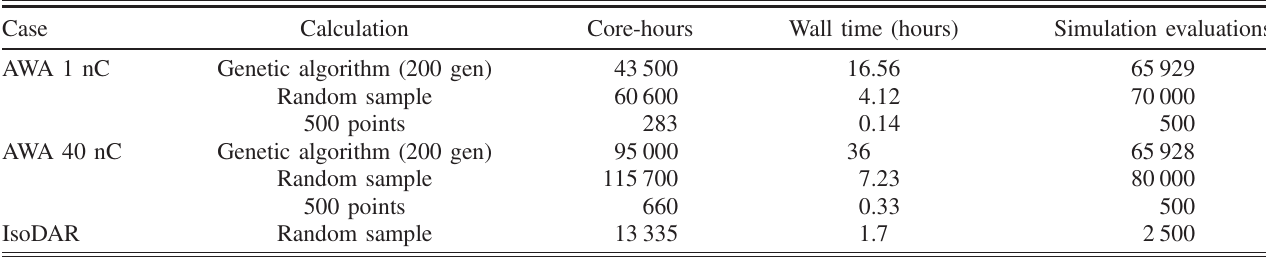
TABLE V. Overview of the datasets from the physics simulations and the computational resources used for generating them. Note that we found that to make accurate surrogate models we needed many fewer randomly sampled points than were initially generated. For the GAs, 2624 cores were used. For the 1 nC random sample, 16k cores were used, and for the 40 nC random sample, 15k cores were